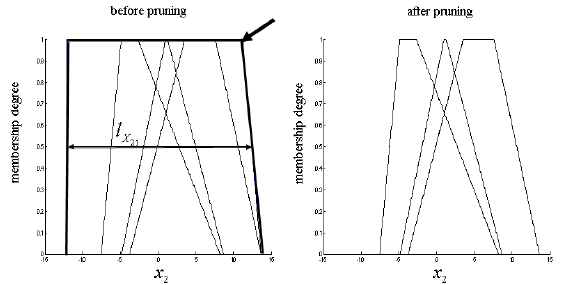
Fig. 7. Overlapping MFs obtained from the clusters projection. The thick solid line in the left Figure denotes the FS X 21 to be pruned